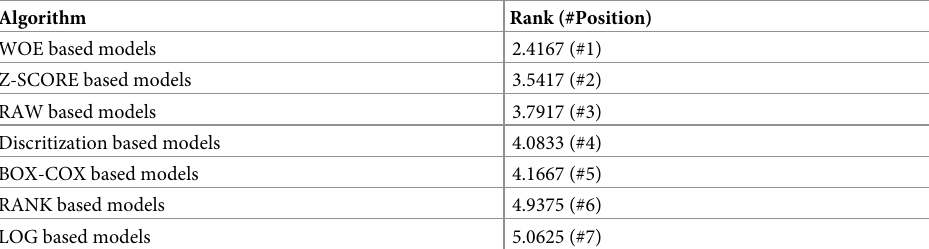
Table 7. Average rankings of the